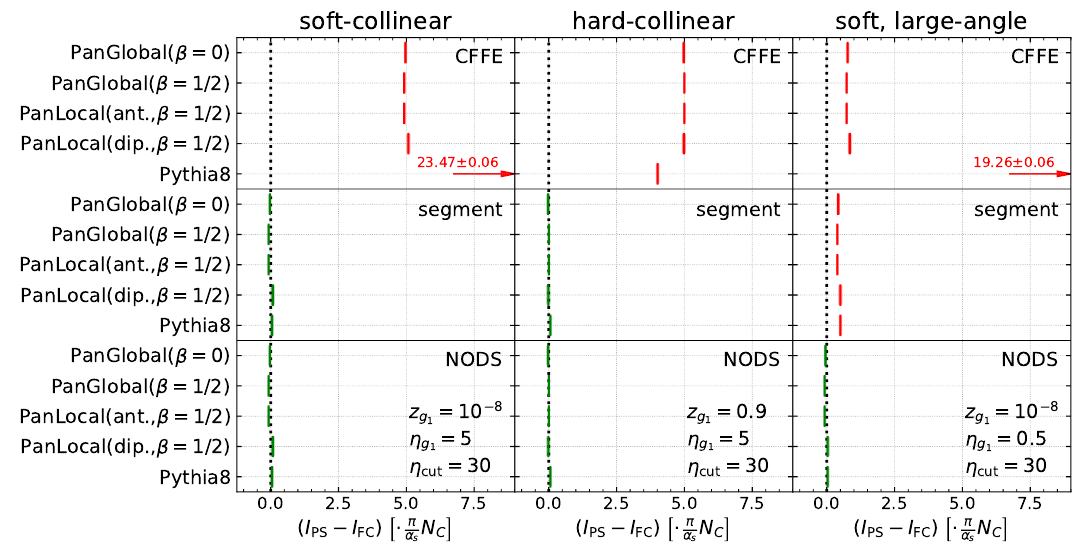
1/2)PanGlobal( = 1/2)PanLocal(ant., = Pythia8PanLocal(dip., =